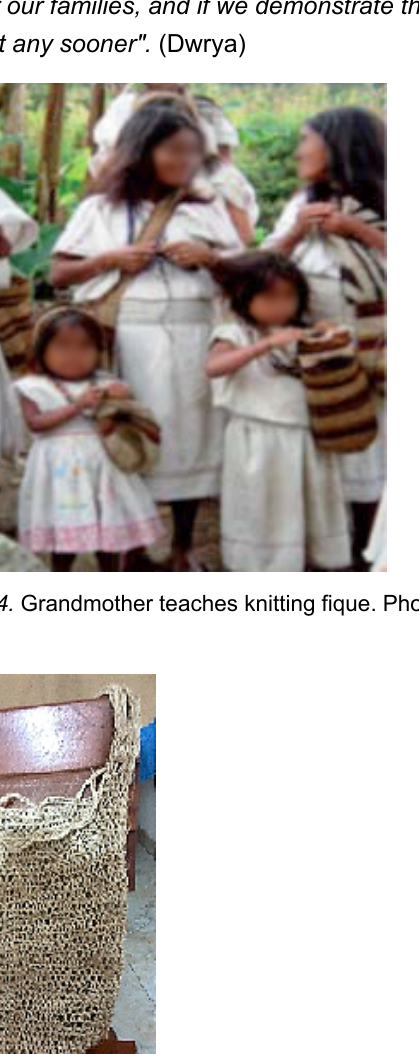
Europe's Journal of Psychology 2016, Vol. 12(2), 242–259